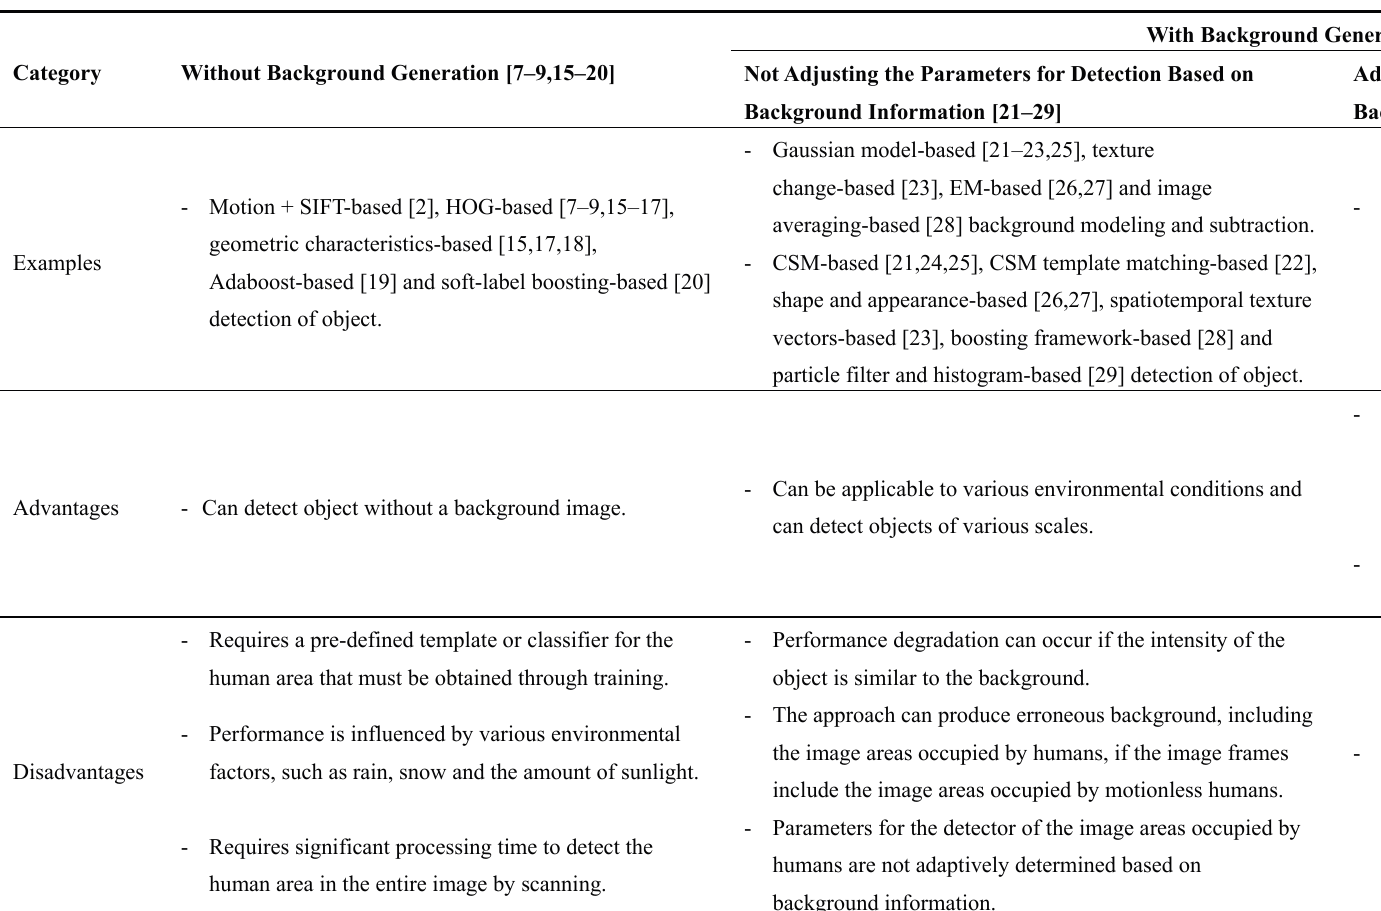
Table 1. Comparison of previous and the proposed methods. HOG, histogram of the oriented gradient; EM, expectation minimization; CSM, contour saliency